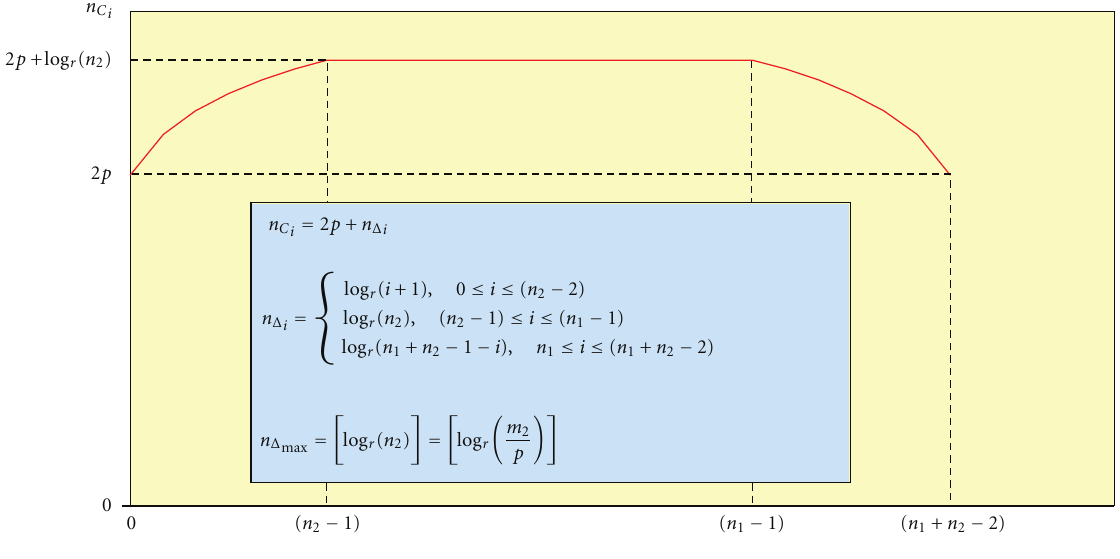
Figure 6: Growth of MAC process (accumulation/carry